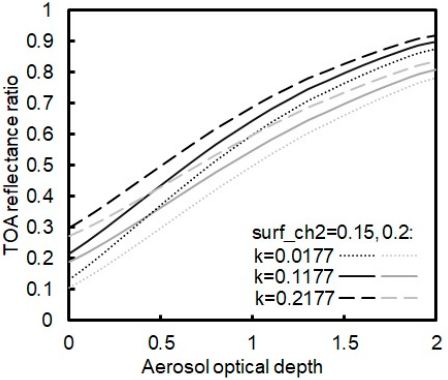
Figure 8. The same as Figure 7 but for different 𝑘′ values.